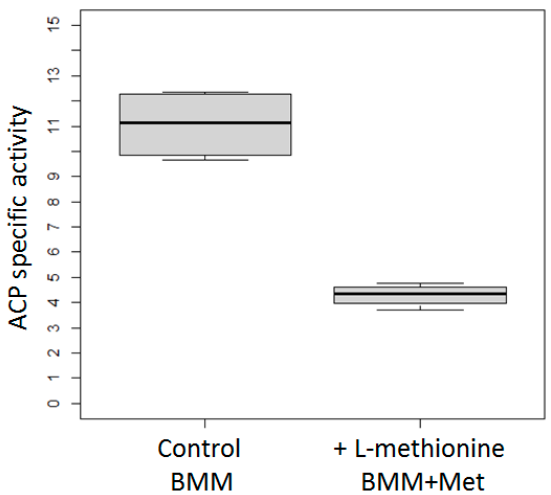
Figure 5. ACP specific activity in the cultures of K. phaffii PAP1-X33 strain after methanol induction in media with or without methionine (BMM and Met, or BMM). The mean from four separate ex- periments with two technical replicates is plotted. Raw data is presented in Table S5 in the Sup- plementary